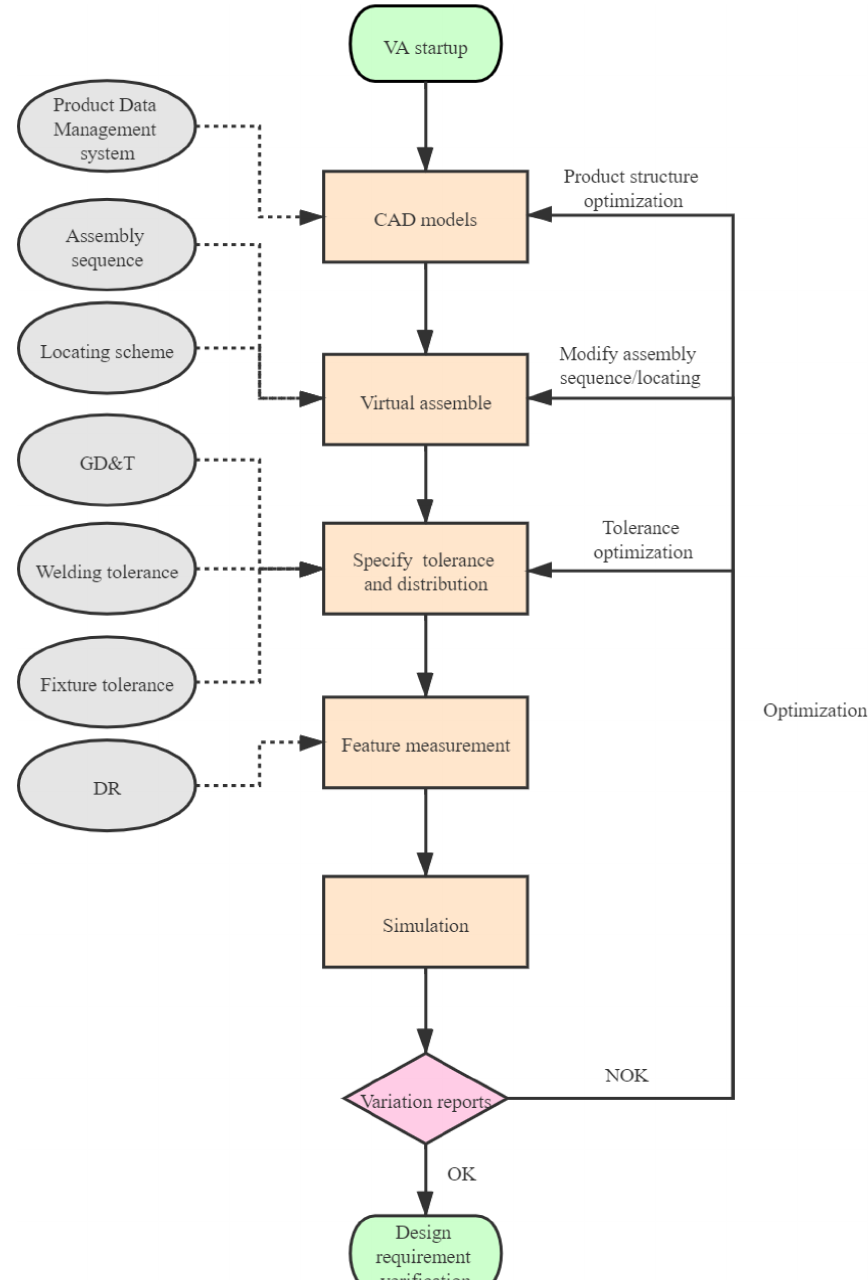
Figure 5. Variation analysis